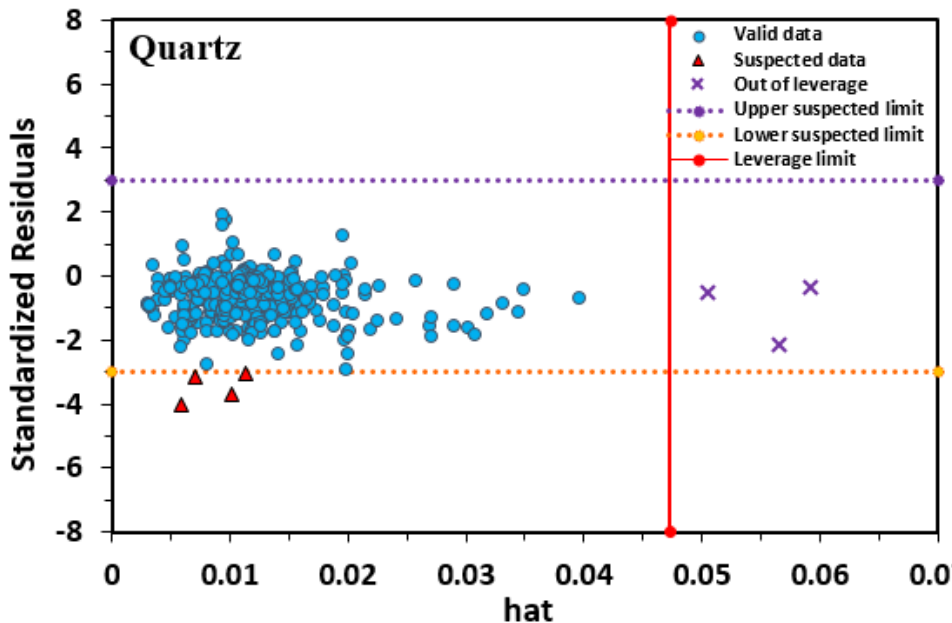
Figure 12. Williams plots of the proposed correlation for the minerals.